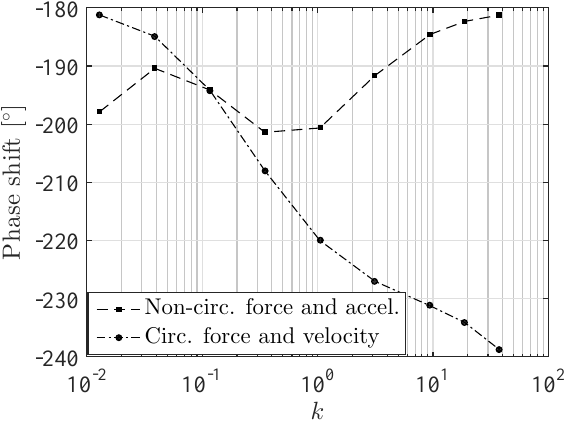
Figure 8. Phase shift between non-circulatory plunge force relative to acceleration and circulatory plunge force relative to velocity for different plunge